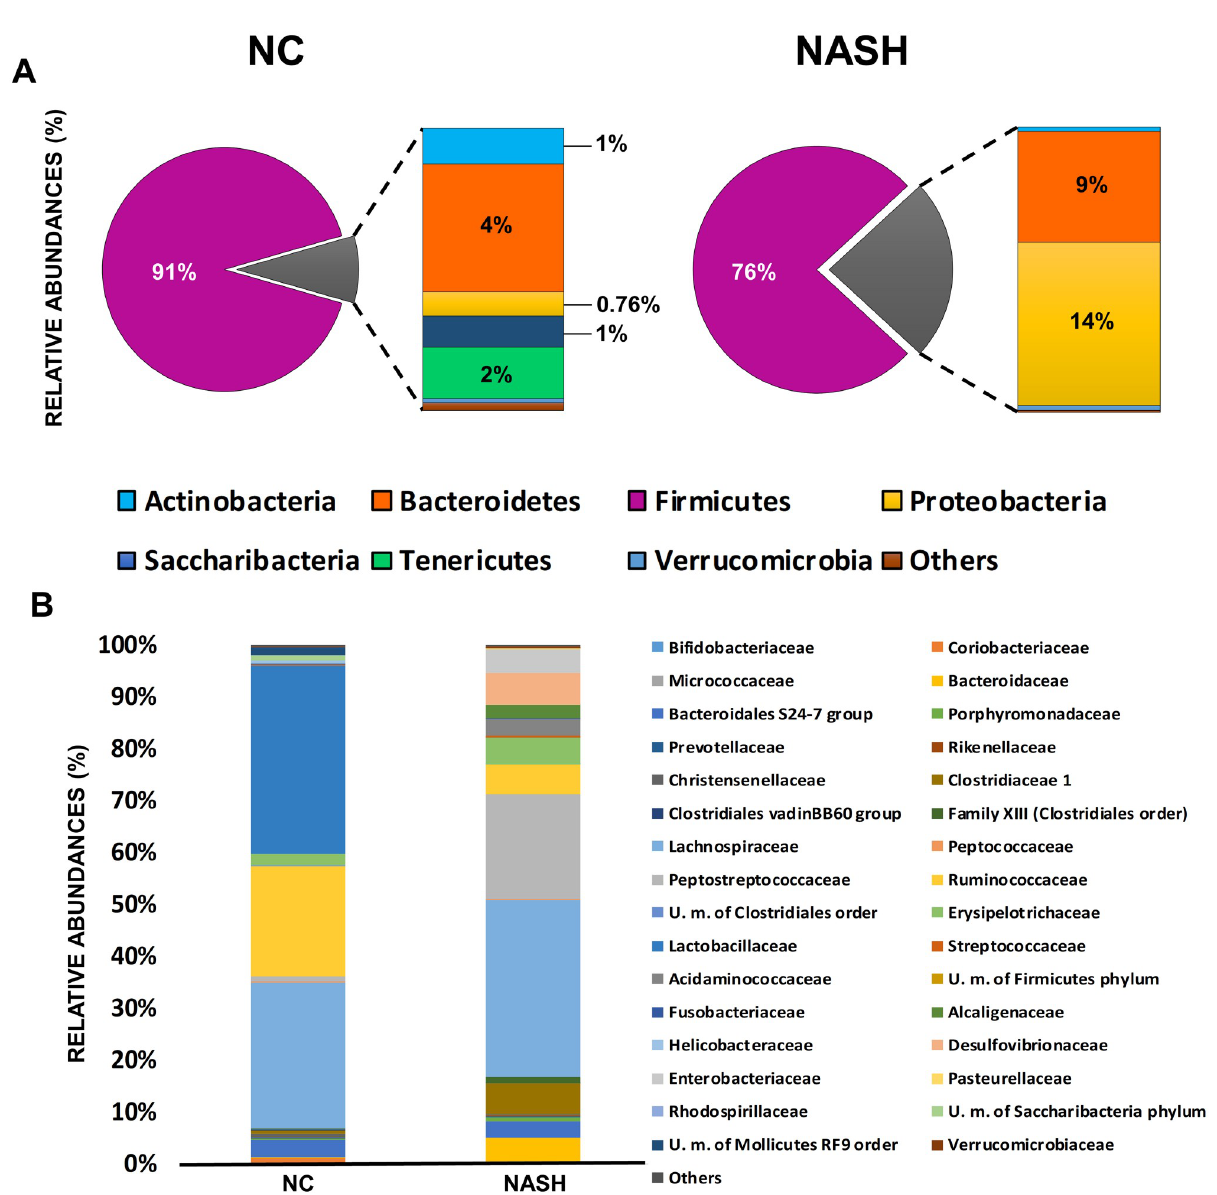
Fig 4. Microbiota population. Relative abundance (%) of bacteria in fecal samples from NC and NASH groups at (A) phylum and (B) family level.